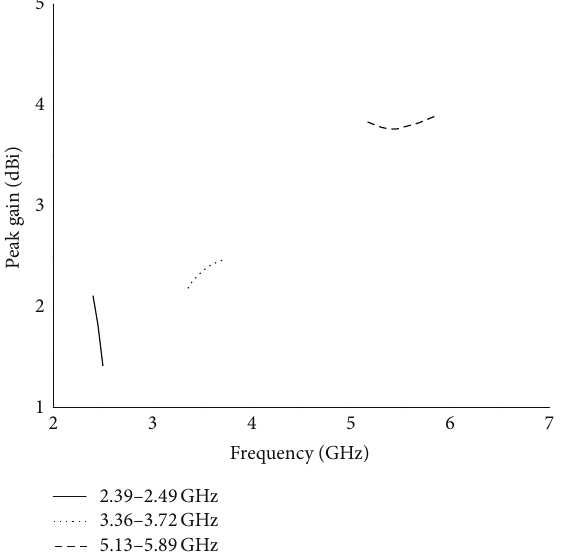
Figure 8: Measured peak gains of the proposed triband antenna.